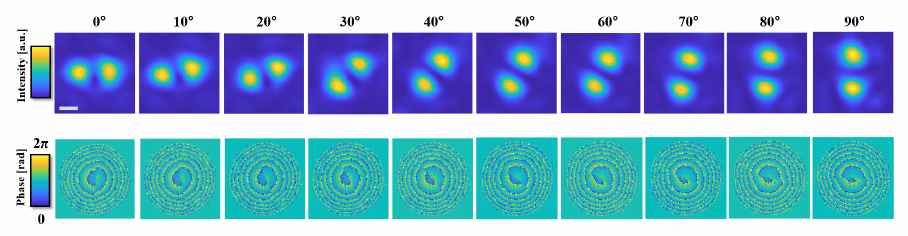
Figure 7. Rotation control of light field through a multi-core fiber with a spatial light modulator. The image sequence on the top row is captured from a experimental rotation of the output dual-spot profile at the distal far-field of the multi-core fiber. The scale bar shows a length of 5 µ m. The image sequence on the bottom row is the corresponding phase modulation generated from the on-the-fly controlled Core-GS algorithm. Both image sequences are sampled from a continuous rotation from 0 ◦ to 90 ◦ in 1 ◦ -steps. (See Video